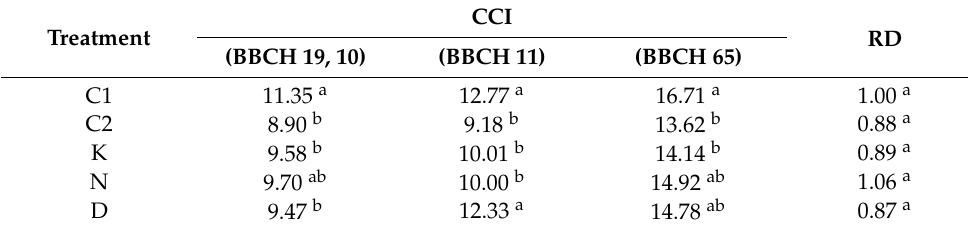
Table 2. Effects of phytostimulators on chlorophyll content index and dark respiration rate in maize leaves. CCI: chlorophyll content index, RD: dark respiration rate; in each column, values followed by different letters indicate statistically significant ( p ≤ 0.05) differences, control treatment under normal growth conditions without cold stress (C1), second control treatment under stress growth conditions with cold (C2), Kelpak ® (K), Nano Active ® (N), Dynamic Cresco ®